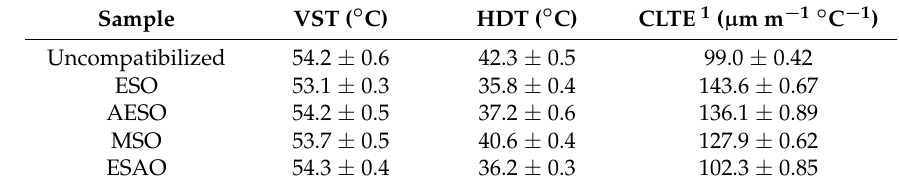
Table 3. Thermomechanical properties of ternary PLA 60 /PHB 10 /PCL 30 blend with different compatibilizers: Vicat softening temperature (VST), heat deflection temperature (HDT) and the coefficient of thermal linear expansion (CLTE) obtained by thermomechanical analysis (TMA).